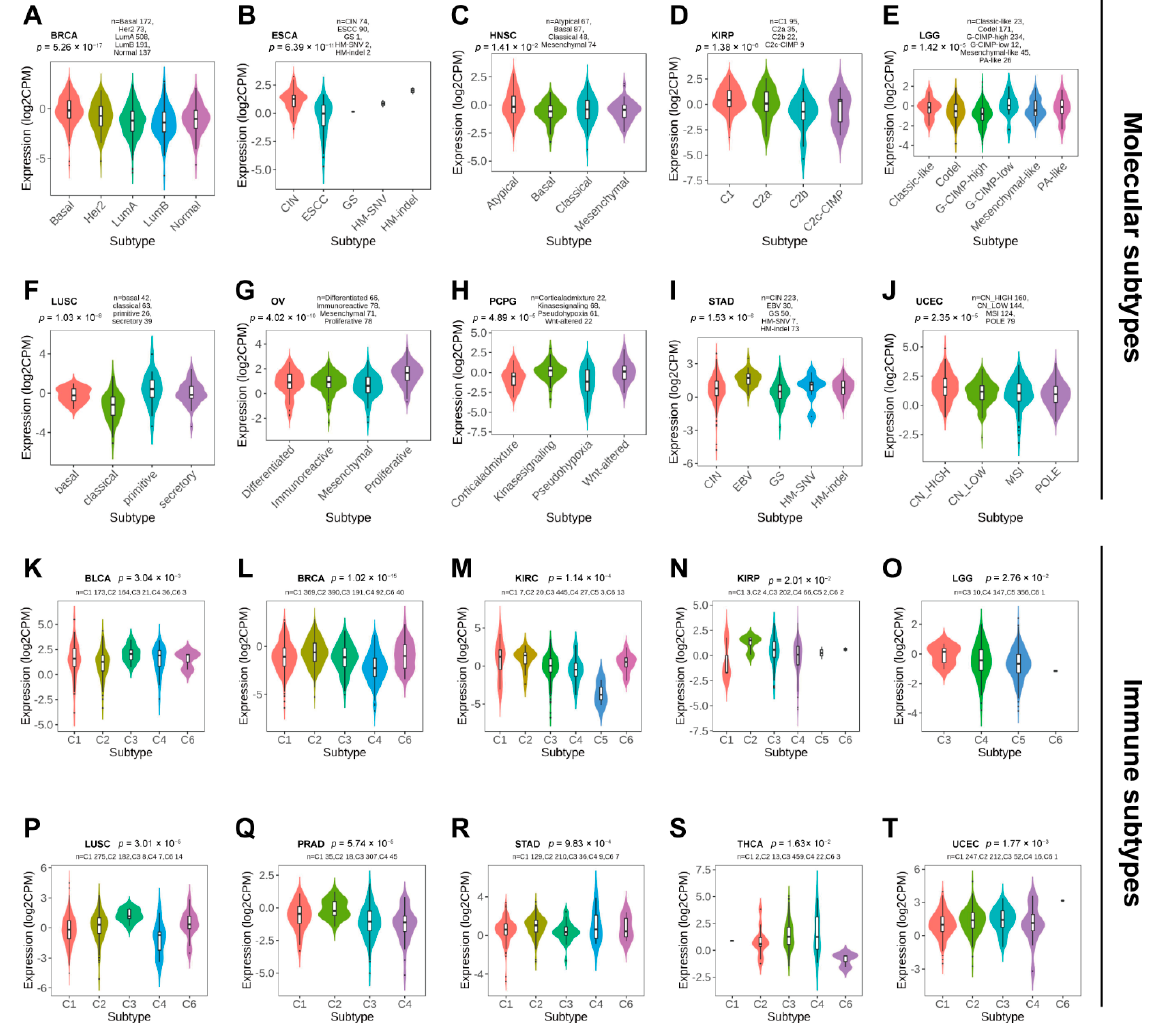
Figure 4. The PBX4 expression in molecular subtypes and immune subtypes across human cancers. Correlations between PBX4 expression and molecular subtypes of ( A ) BRCA, ( B ) ESCA, ( C ) HNSC, ( D ) KIRP, ( E ) LGG, ( F ) LUSC, ( G ) OV, ( H ) PCPG, ( I ) STAD, and ( J ) UCEC. Correlations between PBX4 expression and immune subtypes of ( K ) BLCA, ( L ) BRCA, ( M ) KIRC, ( N ) KIRP, ( O ) LGG, ( P ) LUSC, ( Q ) PRAD, ( R ) STAD, ( S ) THCA, and ( T ) UCEC. C1 (wound healing); C2 (IFN-gamma dominant); C3 (inflammatory); C4 (lymphocyte depleted); C5 (immunologically quiet); C6 (TGF-beta dominant).